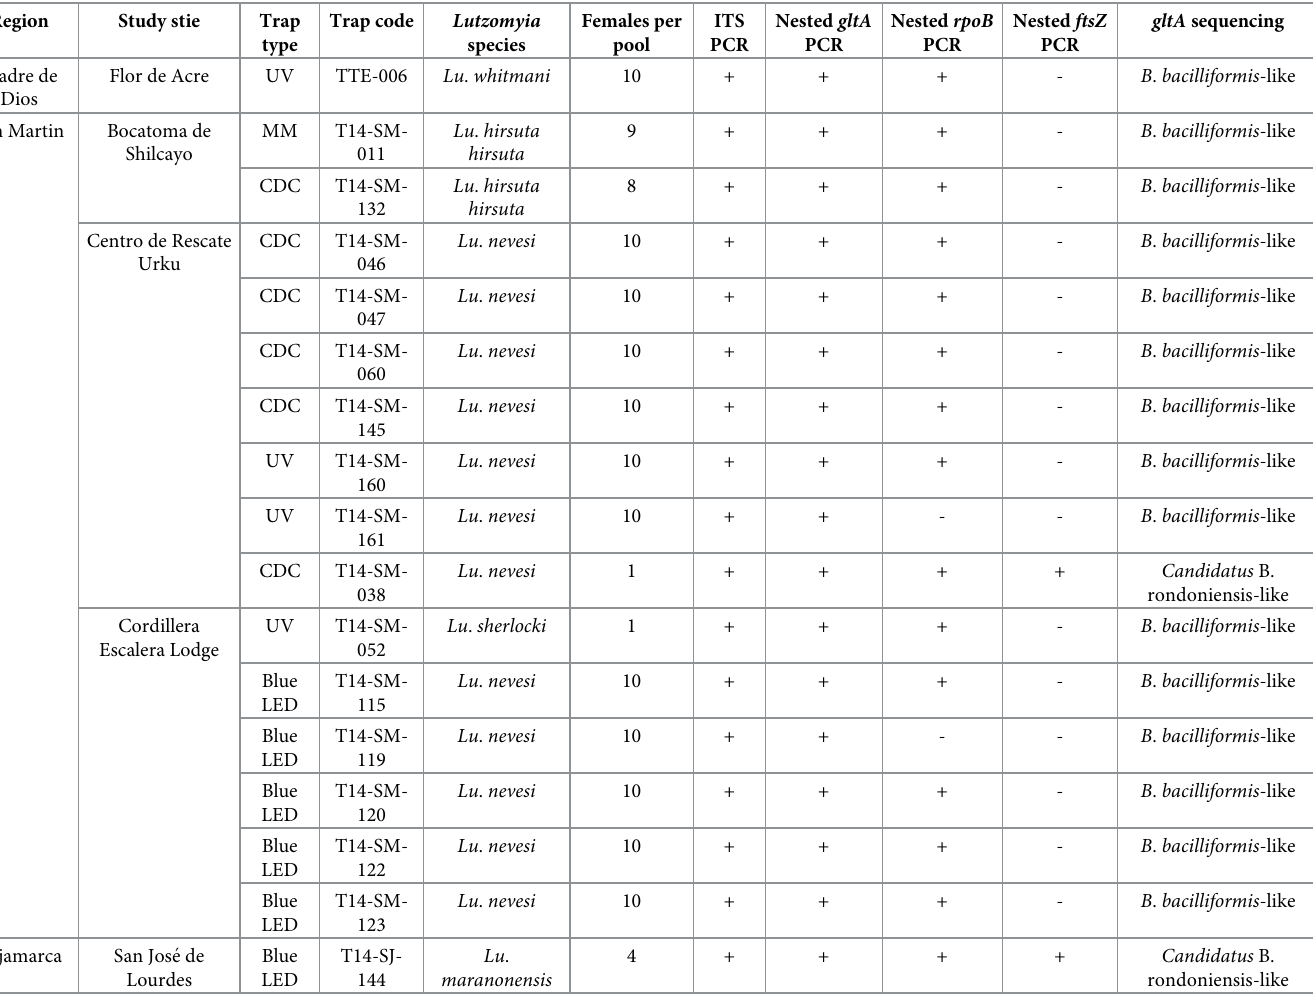
Table 3. Bartonella DNA detection in phlebotomine sand flies from low jungle (Madre de � Dios) and high jungle (San Martin and Cajamarca) regions in Peru. Region Study